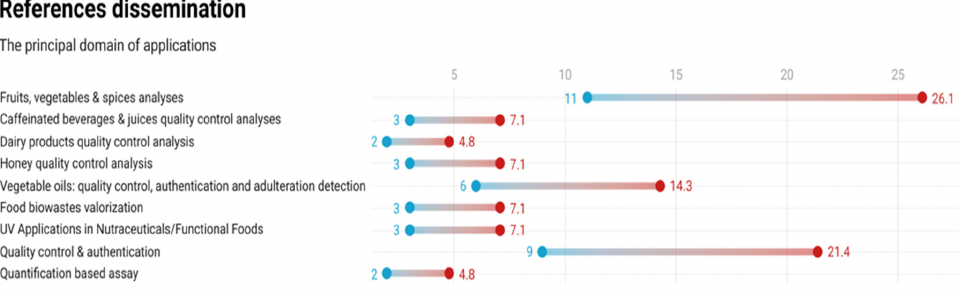
Figure 1. The principal domains of application of the UV-Vis fingerprinting approach and the corresponding references represented as number of references shown with blue circles and as percentages of total references with red circles.